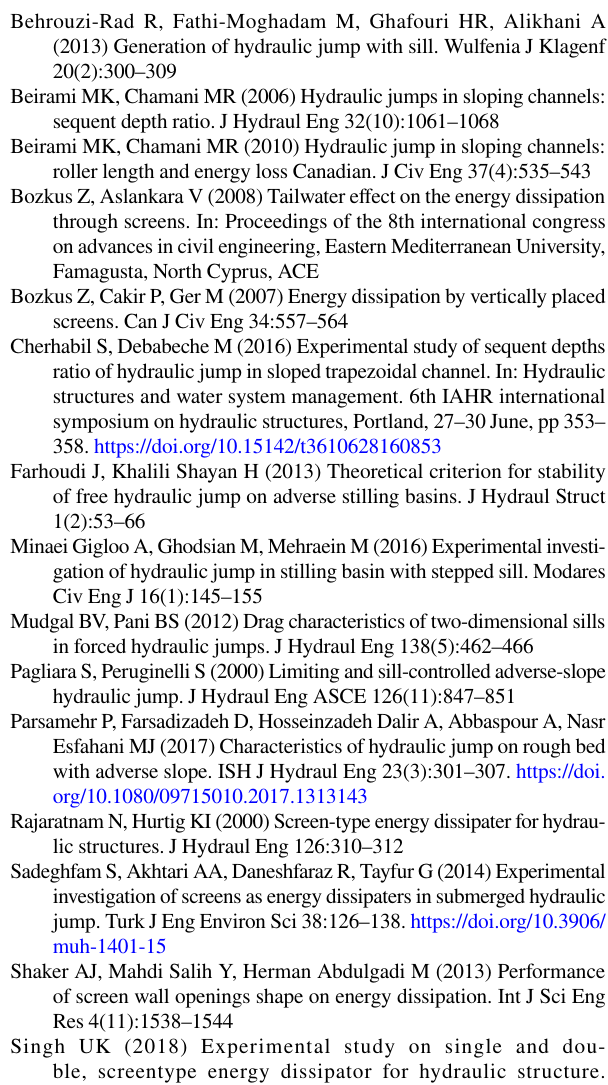
Fig. 9 The comparison of the relative energy dissipation E reverse bed slope with double screens for the current and former stud- ies